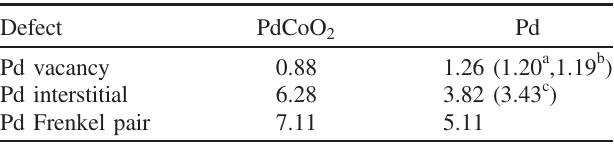
TABLE I. Formation energies in eV for Pd-related native defects in PdCoO 2 and Pd metal. In parentheses are previous DFT GGA calculations.